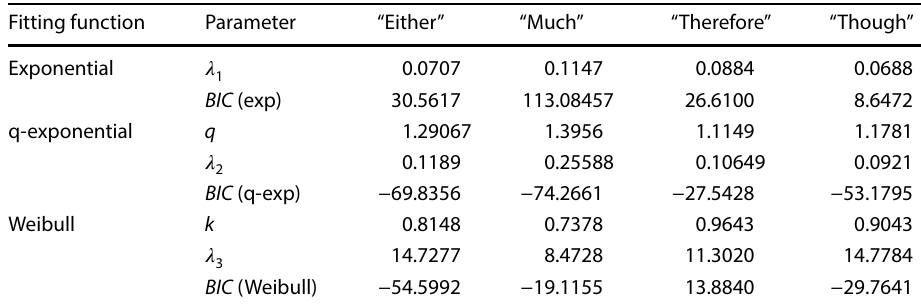
Table 1 Optimized fitting parameters of best fitted curves shown in Fig. 3. The BICs corresponding to each fitting using the exponential, the q-exponential, and the Weibull distributions are also shown as BIC(exp), BIC(q-exp), and BIC(Weibull),